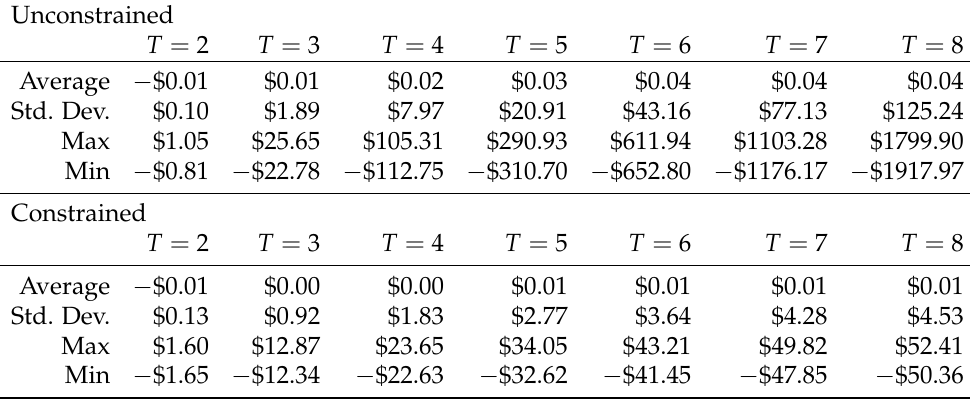
Table 1. Futures’ estimation errors by time to maturity T